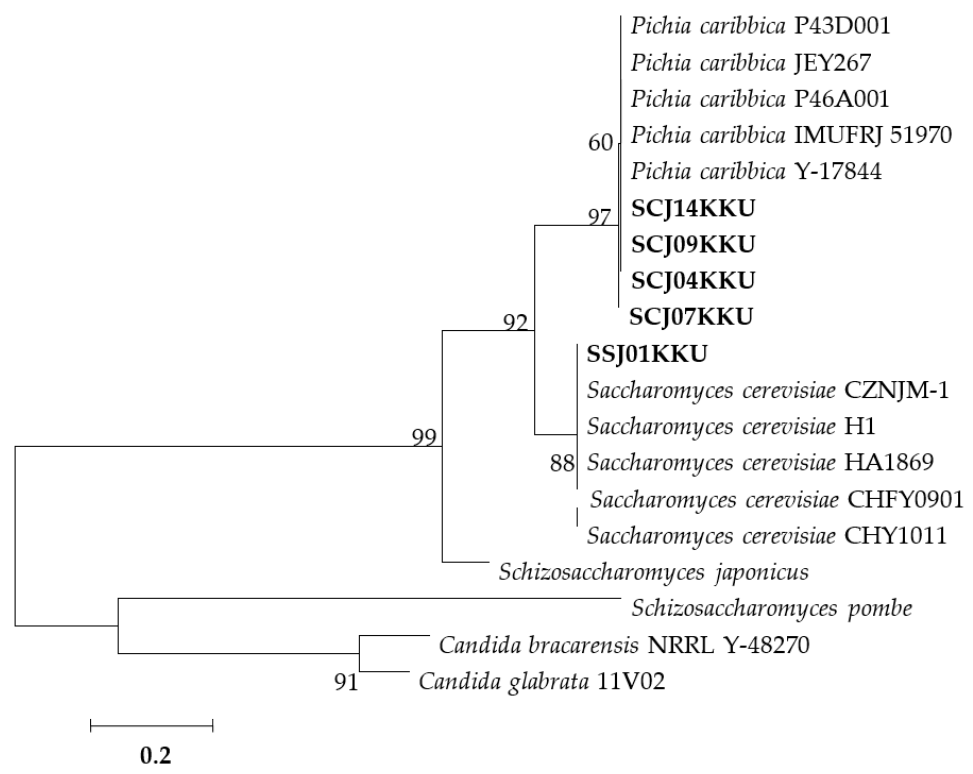
Figure 4. Phylogenetic relationship of SCJ04KKU, SCJ07KKU, SCJ09KKU, SCJ14KKU and SSJ01KKU based on a combined sequence analysis of the D1/D2 domain of 26S rDNA. Clustering was performed using the neighbor-joining method, MEGA (Molecular Evolutionary Genetics Analysis) Version 5. The percentages at the nodes indicate the levels of bootstrap support for the branch point based on 1000 bootstrap replicates. The scale bar represents 0.2 nucleotide substitution per sequence position.